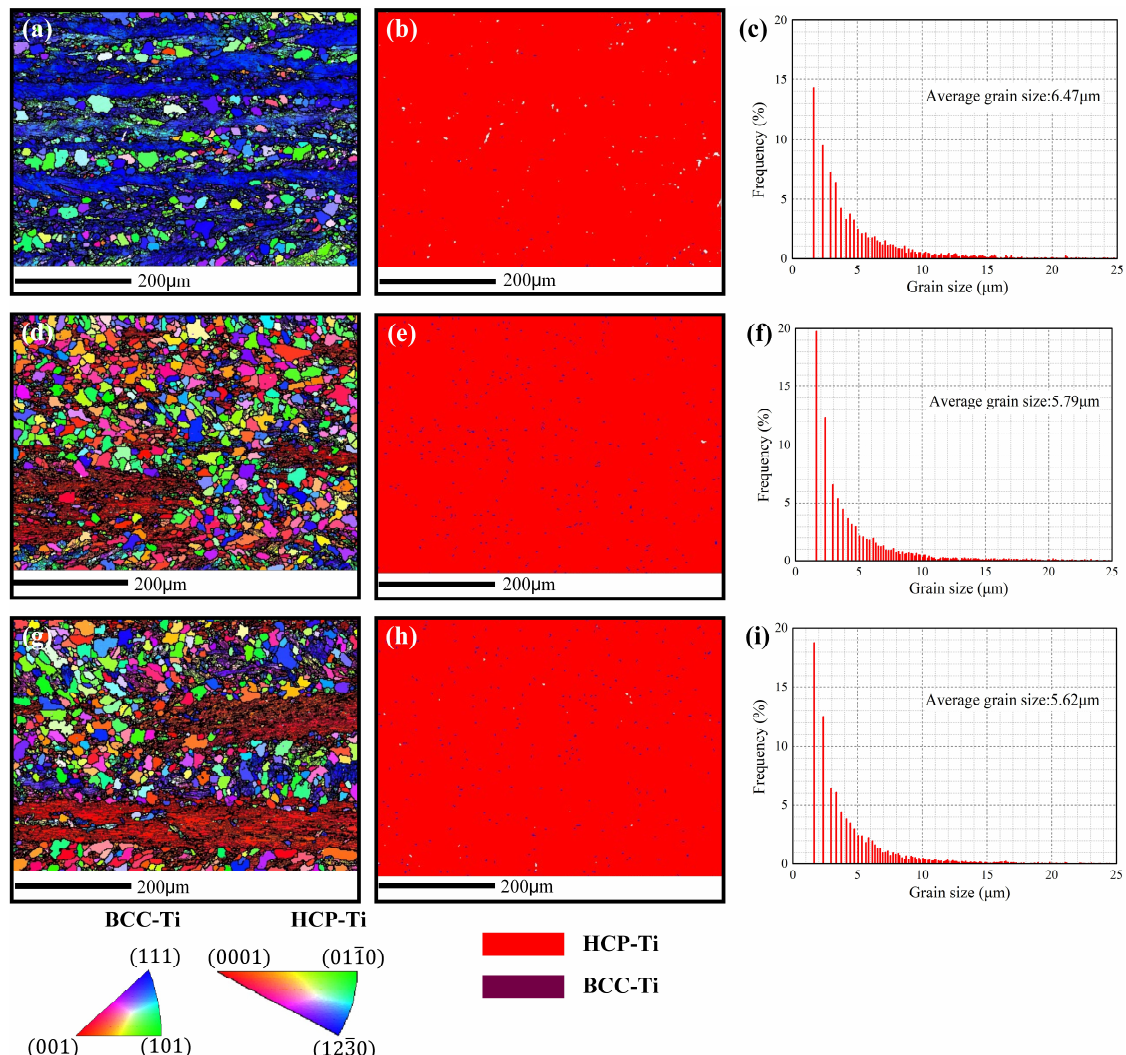
Figure 7. Cross-sectional IPF images, phase distribution and grain size distribution of experimental coupons before and after LSP: ( a – c ) experimental coupon before LSP treatment; ( d – f ) LSP experimental coupon after LSP treatment with one shock; ( g – i ) LSP experimental coupon after LSP treatment with three shocks.